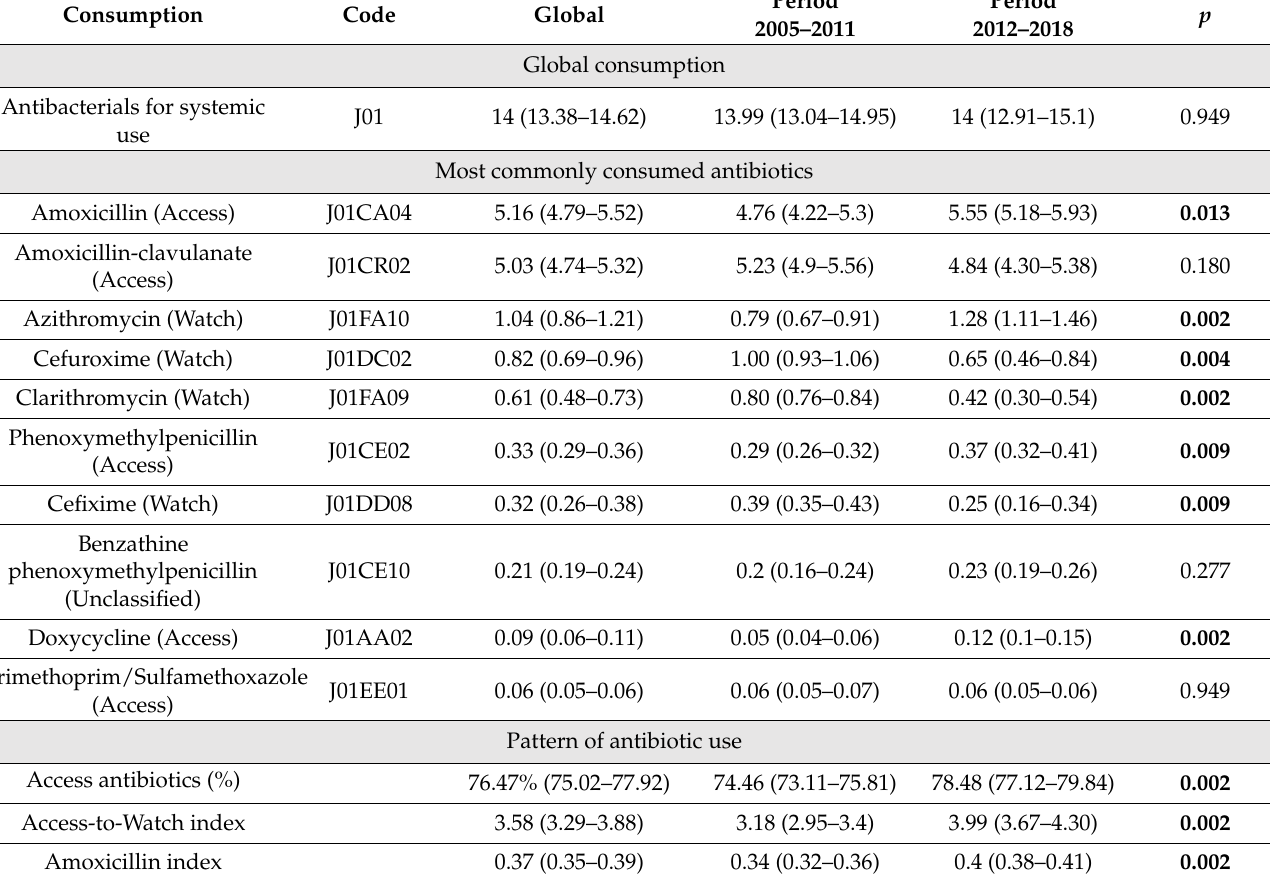
Table 1. Consumption (DID) of total and most commonly used antibiotics and pattern of use in pediatric outpatients in Asturias. Global data and comparison between periods.